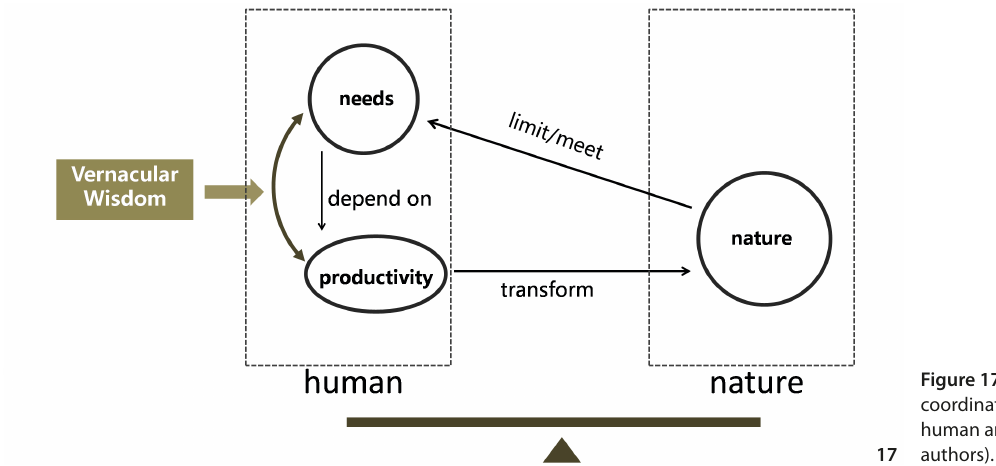
Figure 17 Vernacular wisdom is to coordinate the conflicts between human and nature (Source: the